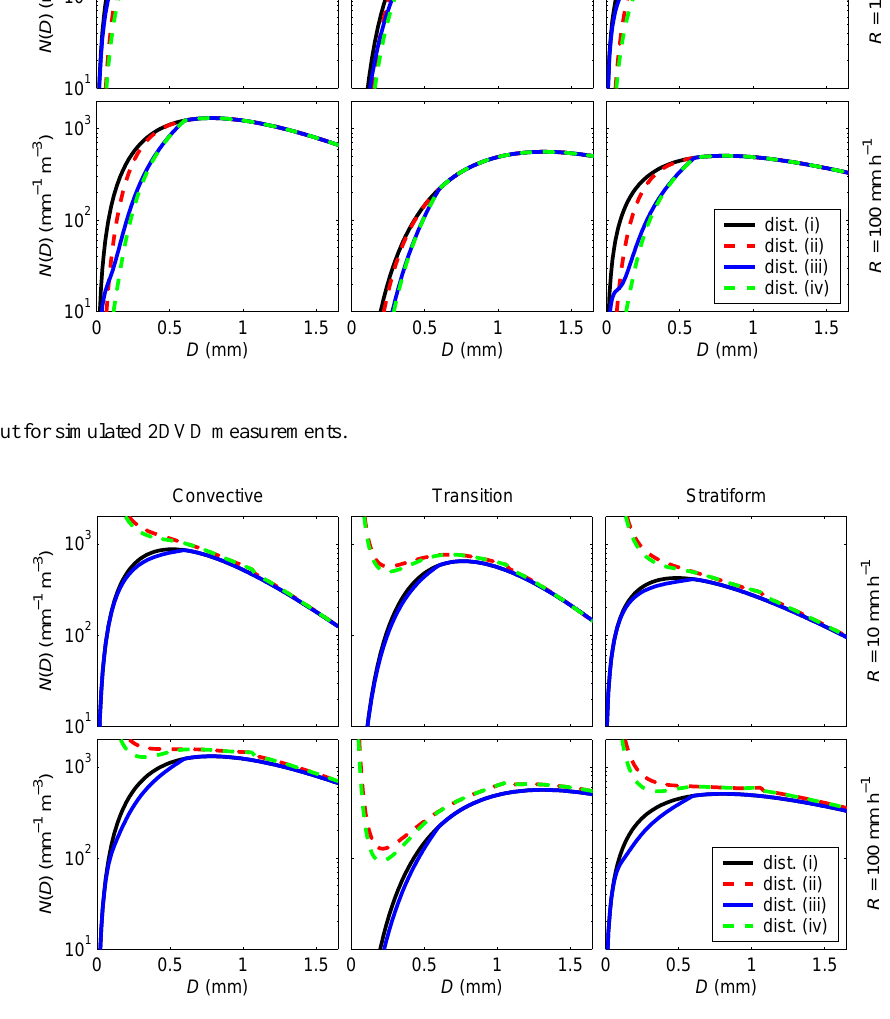
Fig. 6. As Fig. 4, but for simulated measurements from vertically-pointing Doppler